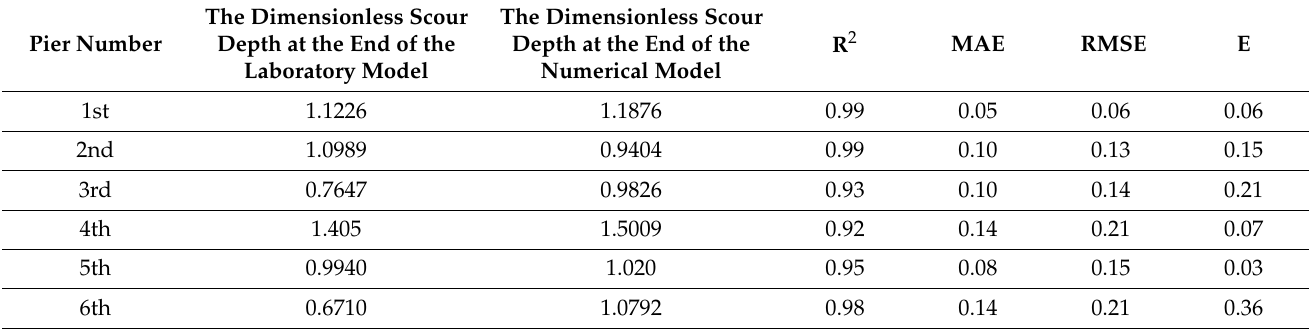
Table 3. Validation of the numerical